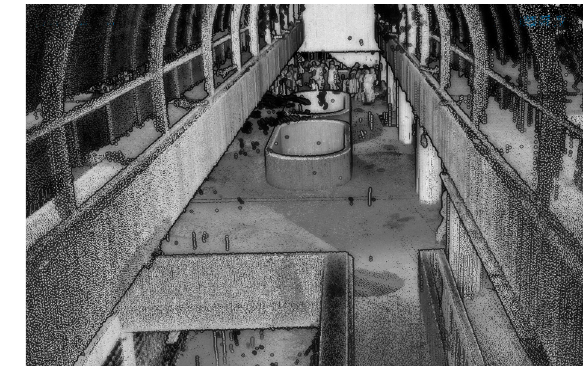
Figure 15. Reflectance perspectiveFigure 14. Point cloud RGB